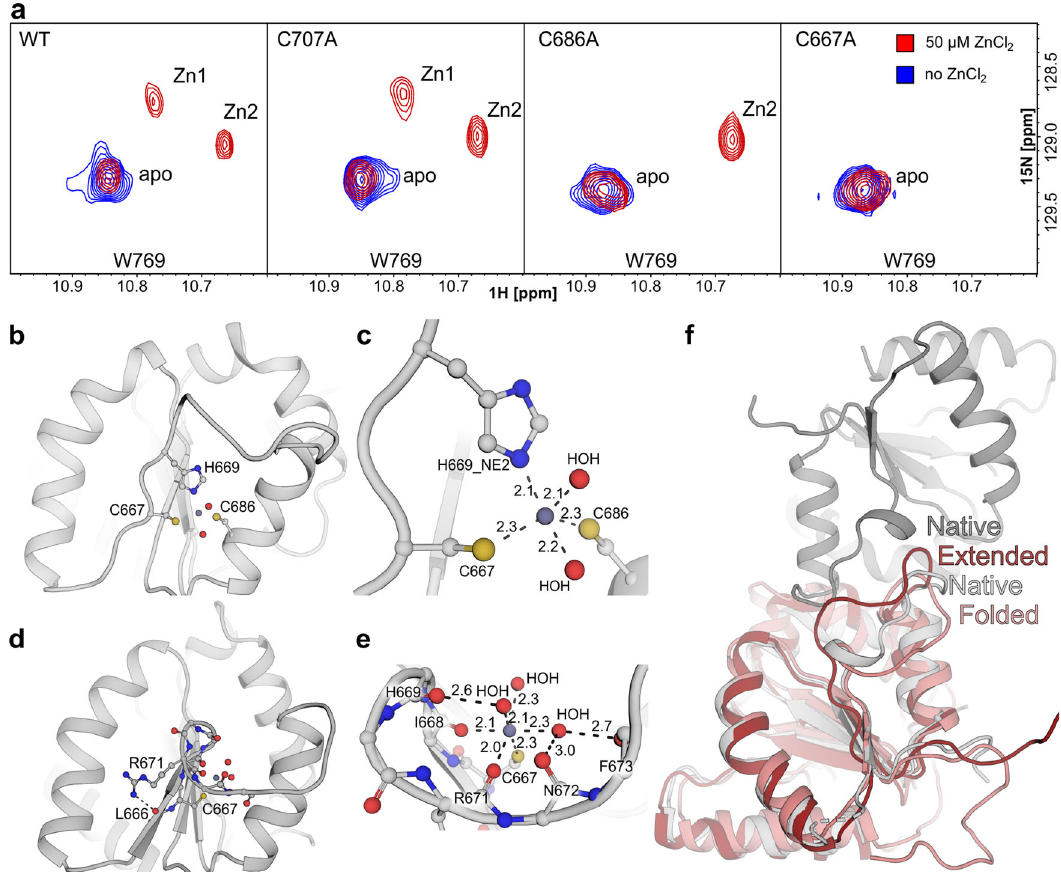
Fig. 4 Localization of TLR1-TIR Zn-binding site and the model of the Zn-bound state. a An overlay of 1 H, 15 N-HSQC spectra (regions with the signal of W769 indole NH) of TLR1-TIR and its mutants C707A, C686A, and C667A. Spectra were recorded before (in blue) and after (in red) the addition of 50 μ M ZnCl 2 to the 100 μ M sample of TLR1-TIR at 30 °C and pH 7.4. Signals corresponding to the Zn-free and two Zn-bound states of TLR1-TIR are assigned as apo, Zn1, and Zn2, respectively. b Snapshot from the simulation of the fi rst coordination mode formed by C667-H669-C686. c Closeup view of the coordination sphere for the C667-H669-C686 coordination mode. d Snapshot from the simulation of second coordination mode formed by C667 and I668_O. Additional coordinators might be represented by the R671_O and water molecules also coordinated by the backbone oxygen of the BB-loop residues. e Closeup view of the Zn2 coordination sphere. f Comparison of the “ extended ” and “ folded ” BB loop conformations with the “ native ” BB-loop conformation in the TLR10